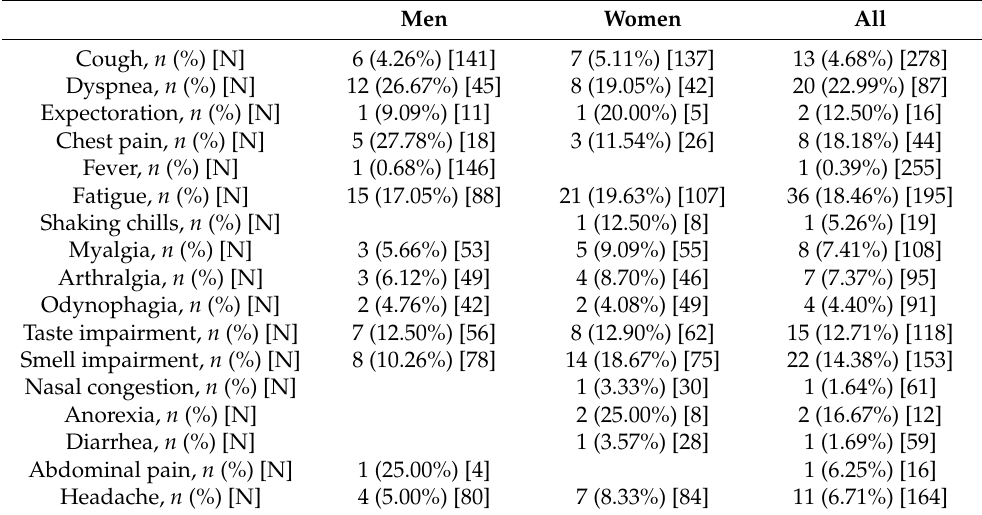
Table 3. Prevalence of persistent symptoms among people with the symptom during the acute